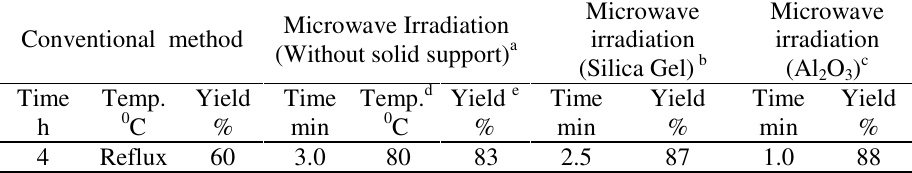
Table 2. Comparative study for the synthesis of melamine-formaldehyde resin microwave irradiation with and without solid